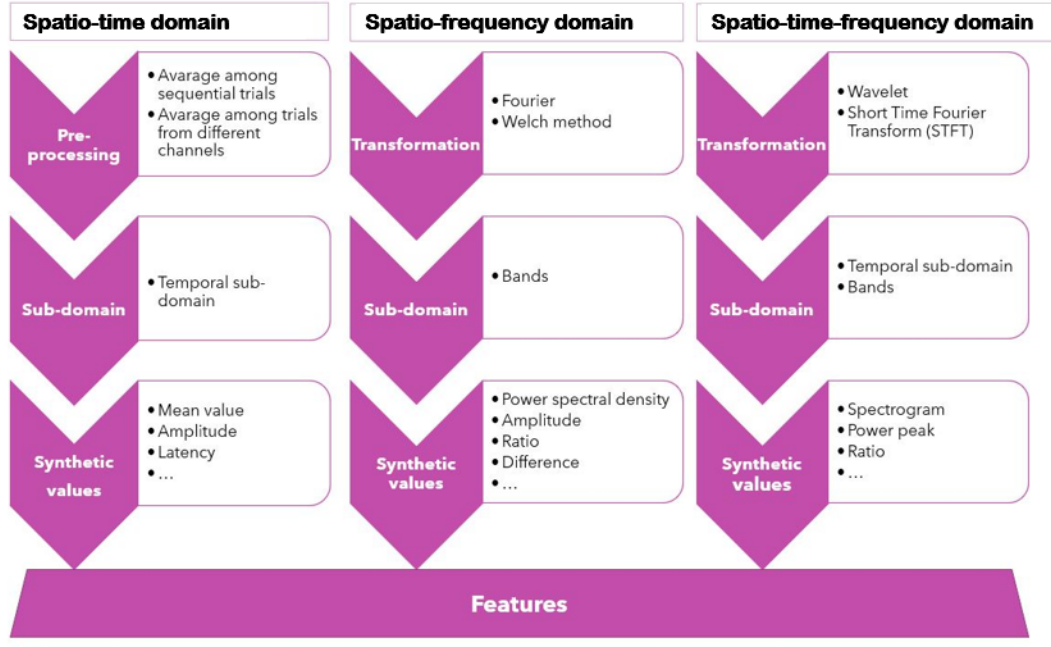
Figure 3. EEG features classification